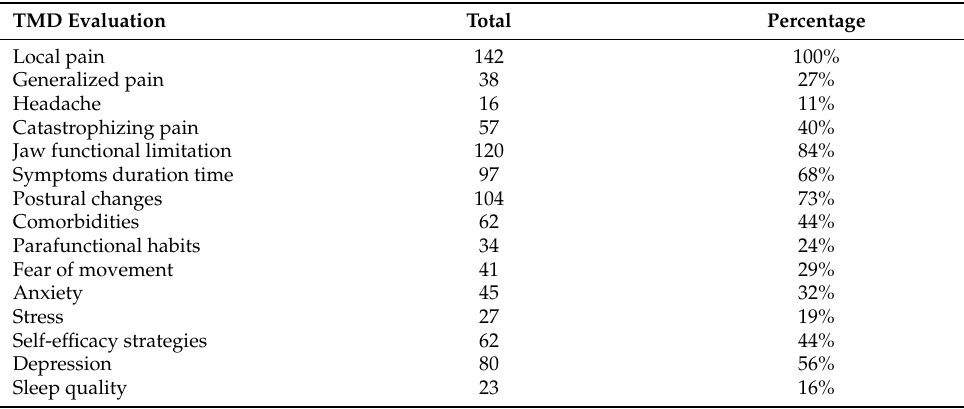
Table 3. Parameters of TMD evaluation most often used ( n =